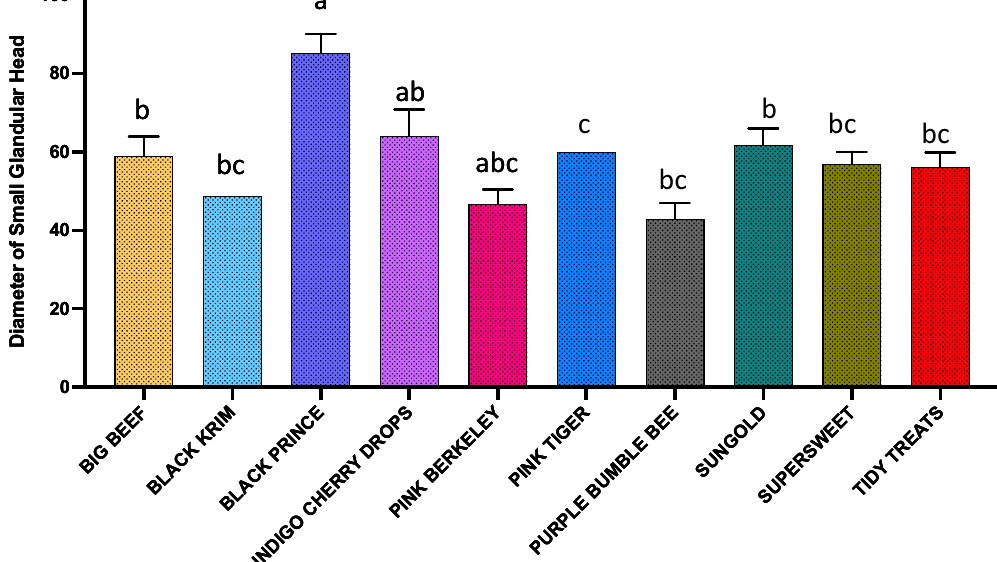
Fig. 10 Comparison of diameter (µm) of small glandular head of attenuate glandular hair with small glandular tip trichome among the ten varieties of